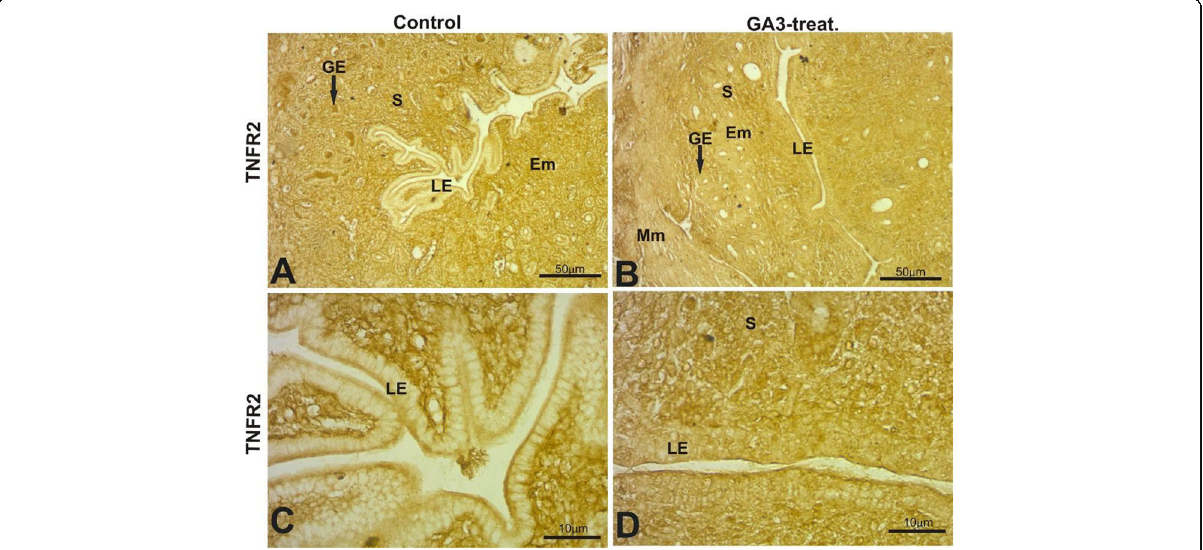
Fig. 2 Photomicrographs of immuno-stained sections of uterine tissues showed TNFR2 expression in the control uterine gland (arrow, a ). GA3-treated group showed a decrease in TNFR2 expression in the uterine gland (arrow, b ). High magnification field showed alteration in TNFR2 expression of the endometrium ( d ) as compared to control ( c ). MM, myometrium; EM, endometrium; LE, luminal epithelium; S, stroma; GE, glandular epithelium. Scale bar = 50 μ m ( a , b ) and 10 μ m ( c , d